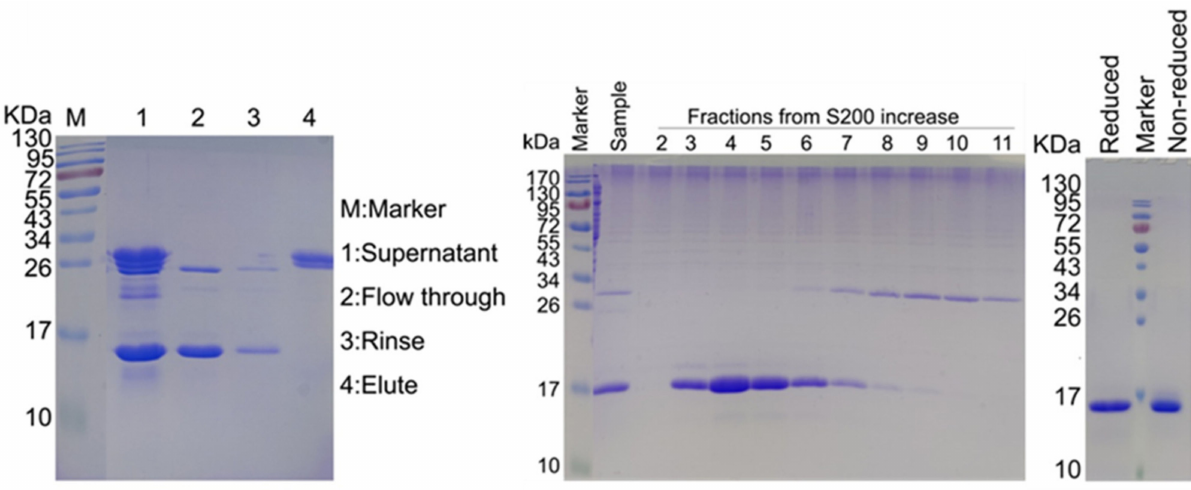
Figure 2. Protein A purification method was used to purify the IMM01-Fab from the supernatant ( left figure). Superdex200 column was used increase purity of IMM01-Fab. Fractions 3, 4, 5 were pooled together for concentration ( middle figure). SDS-PAGE analysis of final purified IMM01-Fab showed a clean single band ( right figure). EEELQVIQPDKSVSVAAGESAILHCTVTSLIPVGPIQWFRGAGPARELIYNQKEGHFP RVTTVSESTKRENMDFSISISAITPADAGTYYCVKFRKGSPDTEFKSGAGTELSVRAKPSAP VVSGPAARATPQHEPKSCDKTHTCPPCPAPELLGGPSVFLFPPKPKDTLMISRTPEVTCVV VDVSHEDPEVKFNWYVDGVEVHNAKTKPREEQYNSTYRVVSVLTVLHQDWLNGKEYK CKVSNKALPAPIEKTISKAKGQPREPQVYTLPPSRDELTKNQVSLTCLVKGFYPSDIAVEW ESNGQPENNYKTTPPVLDSDGSFFLYSKLTVDKSRWQQGNVFSCSVMHEALHNHYTQK